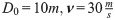
Chapman’s strategy for initial conditions D0=10m,ν=30ms, without perturbations, and for an adversarially chosen tangent reference velocity θ˙ref∼=0.1885 (deviating by −0.02 from the consistent θ˙ref*=0.2085).The agent implements the COV strategy which is described in Section 4.3, using the simulation setup from Section 4.4. We see that the agent initially runs in the wrong direction, away from the ball, before turning at t = 0.8 to head towards the ball. While this deviation still allows the agent to catch the ball, θ˙ref∼=0.161 (deviation of −0.027 from θ˙ref*) would already result in an unsuccessful catch. Top left: agent and ball position. Top right: tangent of the vertical viewing angle and its derivatives; the dotted black line indicates the consistent θ˙ref* value, the dotted gray line indicates the adversarially chosen inconsistent θ˙ref∼. Bottom left: agent velocity (dashed lines denote velocity contraints). Bottom right: agent acceleration (dashed lines denote acceleration constraints).